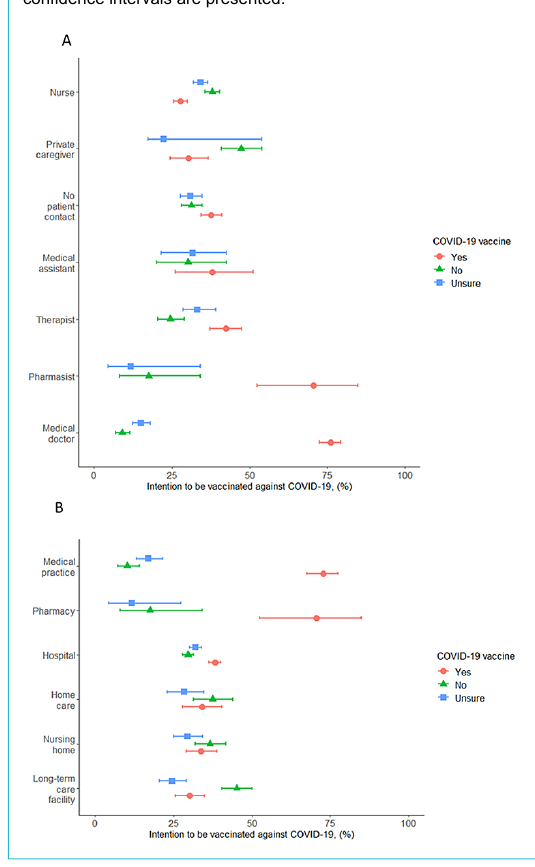
Figure 1: Number of people reporting willingness to be vaccinated against COVID-19 in the Canton of Solothurn, Switzerland by healthcare profession (A) and by workplace (B). Percent with 95% confidence intervals are